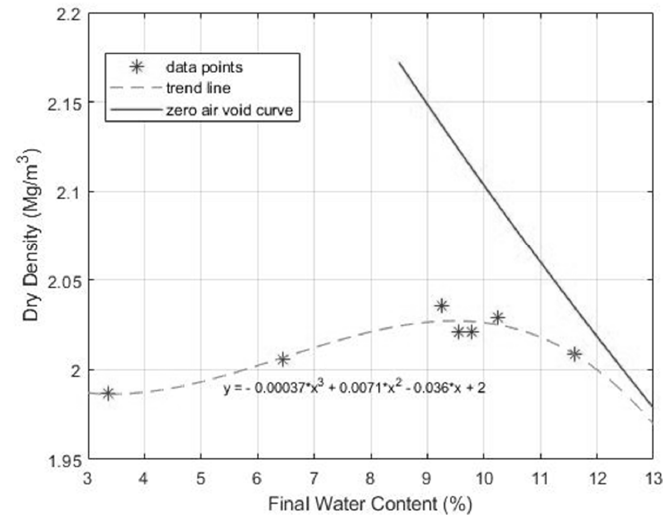
Figure 5. Variation of compacted dry density versus final water content.